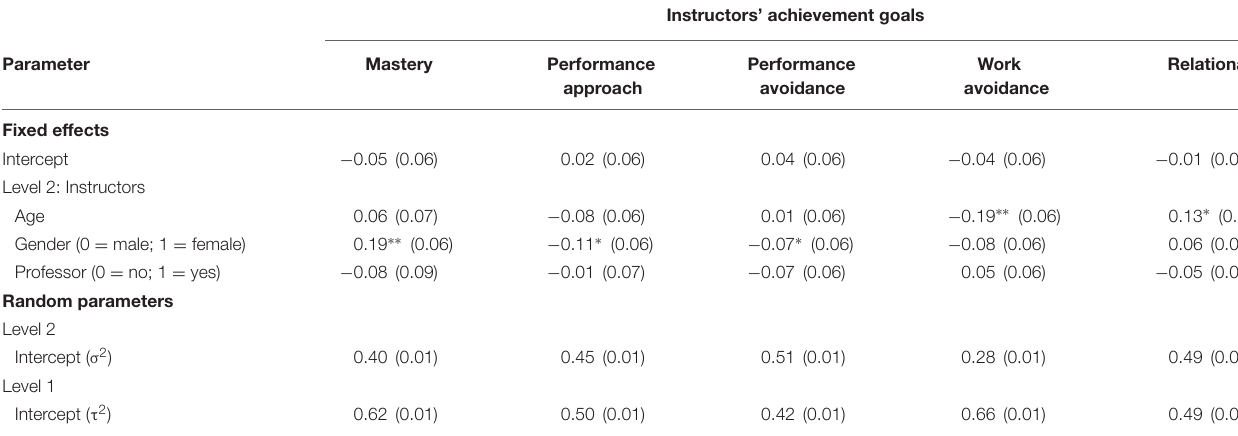
TABLE 3 | Relation of instructors’ achievement goals with age, gender, and career status.